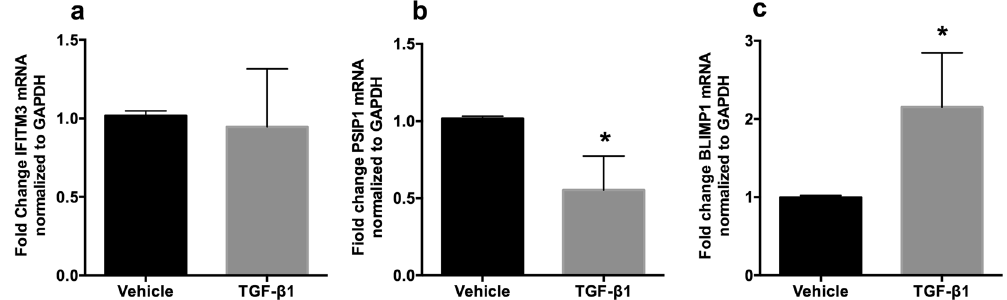
Figure 2. TGF- β signaling alters mRNA expression of HIV-1 host restriction factors in NHBE cells. NHBE ALI cultures were treated with recombinant TGF- β 1 (10 ng/ml; vehicle as control). 48 hours post-treatment, total RNA was isolated and mRNA levels of IFITM3, PSIP1 and BLIMP-1 were determined by qRT-PCR. ( a ) TGF- β 1 does not alter expression of IFITM3 mRNA. ( b ) TGF- β 1 suppresses PSIP1 mRNA. ( c ) TGF- β 1 increases mRNA levels of BLIMP-1 compared to vehicle treated controls. n = NHBE ALI cultures from 3 different lungs; * significant (p < 0.05).